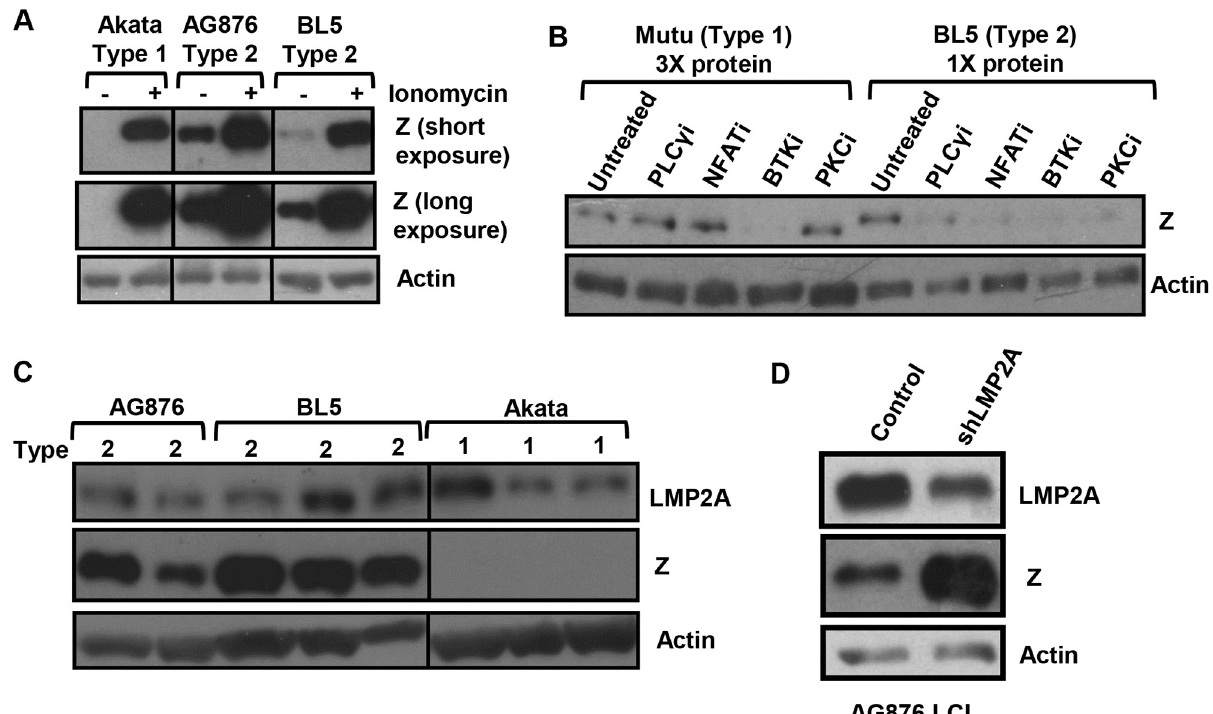
Fig 8. T2 EBV lytic infection depends upon NFAT, PLC γ , BTK, and PKC activity. A) T1 and T2 EBV-infected LCLs were treated with ionomycin for 48 hours and immunoblot analysis performed using antibodies that detect EBV Z protein or cellular actin as indicated. B) T1 and T2 LCLs were treated with inhibitors that target various components of the BCR pathway, including the PLC γ inhibitor, U73133, the NFAT inhibitor, cyclosporin A, the BTK inhibitor, Ibrutinib, and the PKC inhibitor, PKC412. Extracts were harvested 48 hours and immunoblot analysis was performed using antibodies against the EBV Z protein and actin as indicated. Note that three times more protein is loaded in the T1 Mutu lanes to normalize for differences in the level of constitutive Z expression. C) . Immunoblot analysis was performed on whole cell lysates from T1 and T2 EBV-infected LCLs using antibodies against LMP2A (an EBV latency protein), Z, and actin as indicated. D) AG876 T2 EBV-infected LCLs were stably transduced with lentiviruses expressing control or LMP2A targeted shRNAs and cell lines were generated. Immunoblot analysis was performed using antibodies against LMP2A (latency gene), Z, and actin as